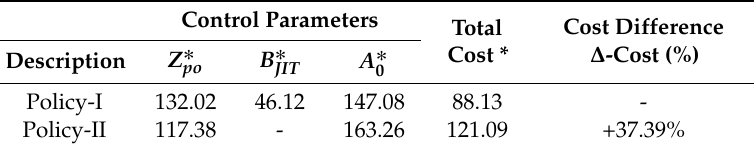
Table 8. Cost difference of the comparative